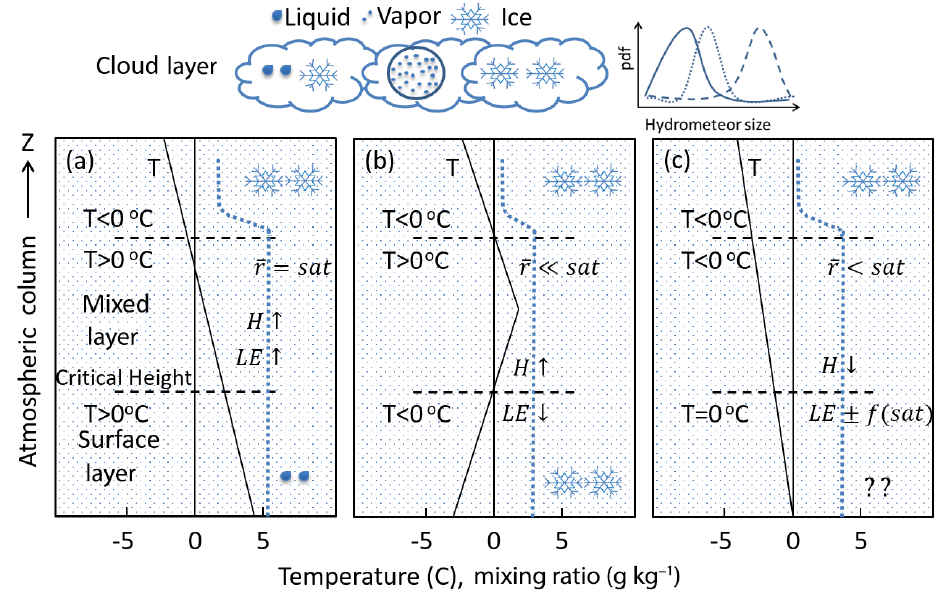
Figure 2. The phase of precipitation at the ground surface is strongly controlled by atmospheric profiles of temperature and humidity. While conditions exist that are relatively easy to predict rain (a) and snow (b) , many conditions lead to complex heat exchanges that are difficult to predict with ground-based observations alone (c) . The blue dotted line represents the mixing ratio. H , LE , f (sat), and r are abbreviations for sensible heat, latent heat of evaporation, function of saturation, and mixing ratio, respectively. The arrows after H or LE indicate the energy of the hydrometeor either increasing (up) or decreasing (down), which is controlled by other atmospheric